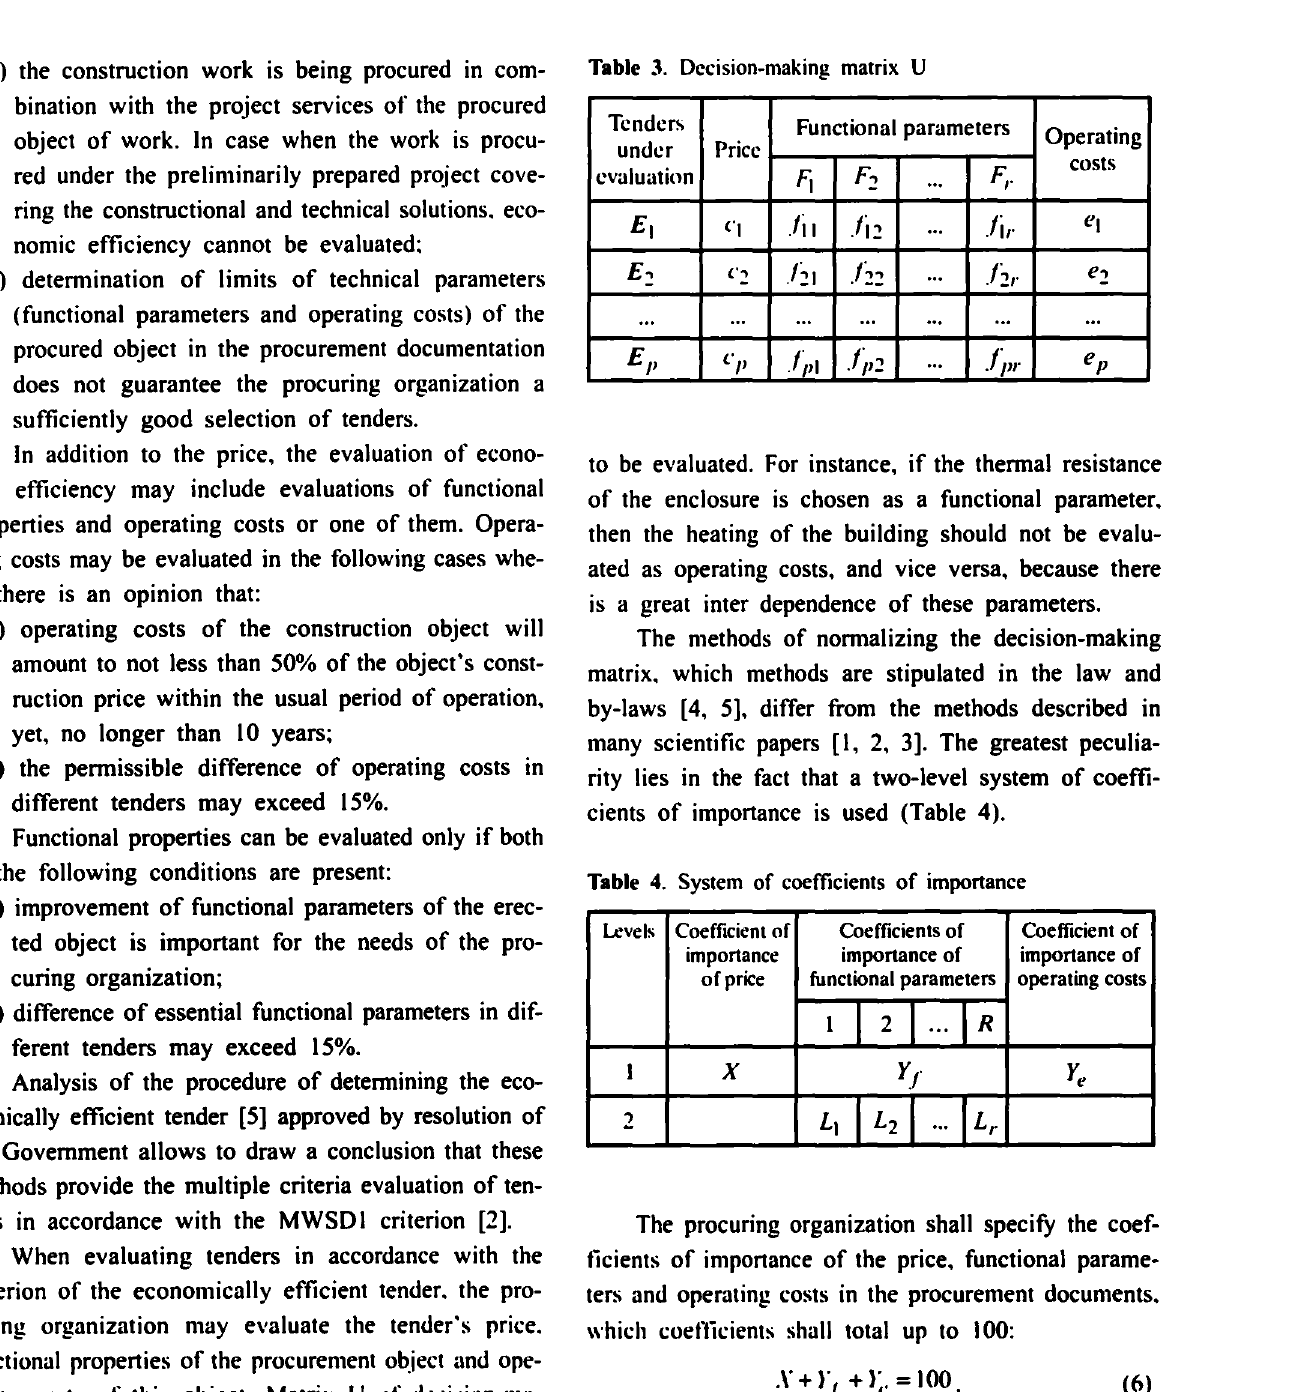
Table 4. System of coefficients of importance Levels Coefficient